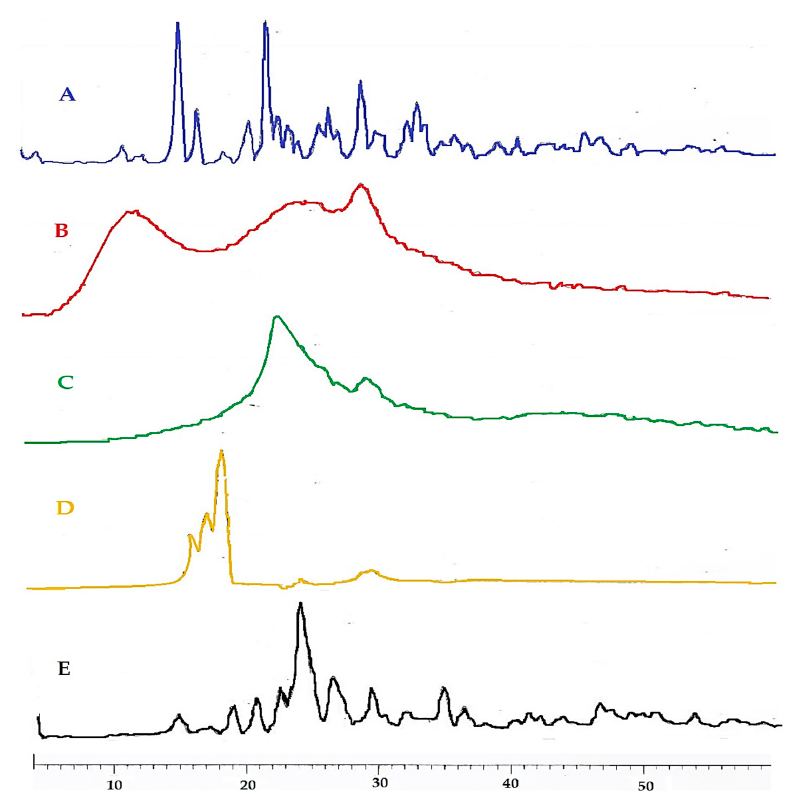
Figure 3. XRD profile of pure TLM ( A ); pure CP ( B ); pure CCS ( C ); pure camphor ( D ) and physical mixtures of TLM/all excipients ( E ).